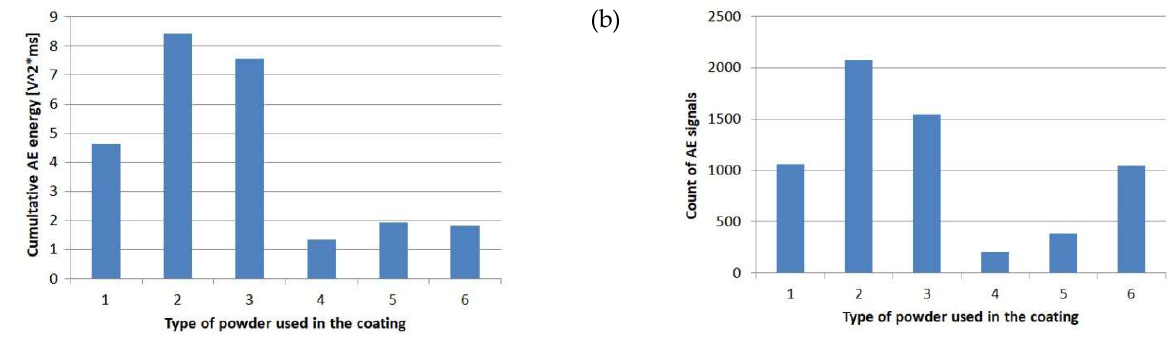
Figure 18. AE results: ( a ) acoustic emission energy E AE ; and ( b ) number of acoustic emission events.